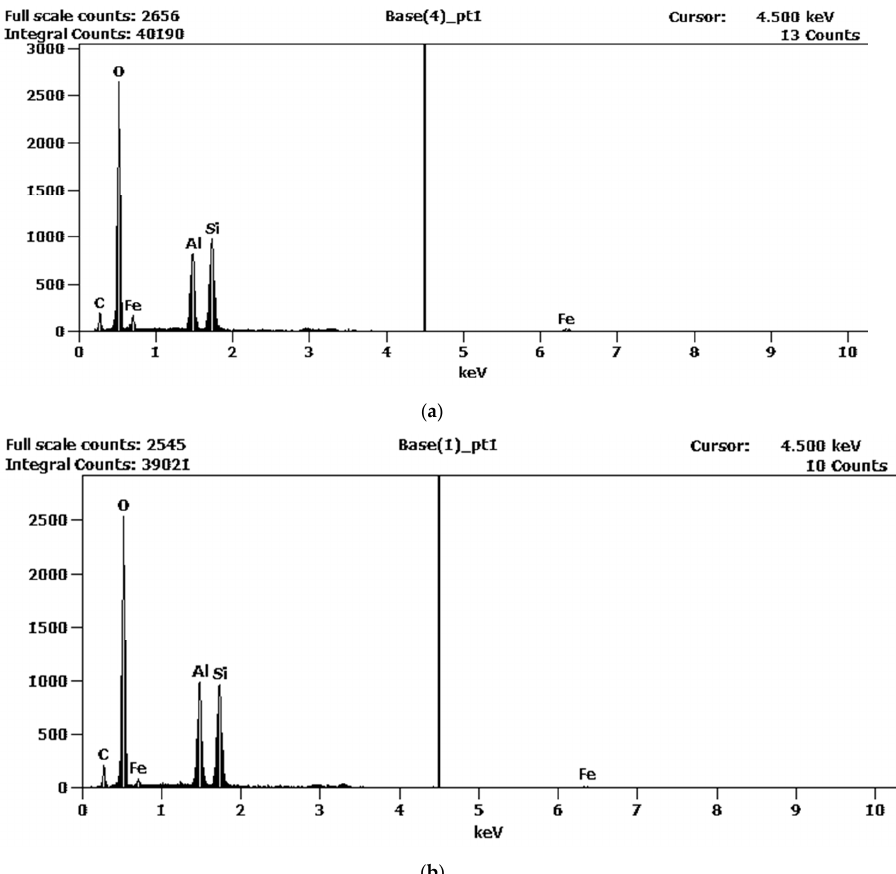
Figure 10. EDS spectrum of Point 1 according to Figure 9a ( a ); EDS spectrum of Point 1 according to Figure 9b ( b ).